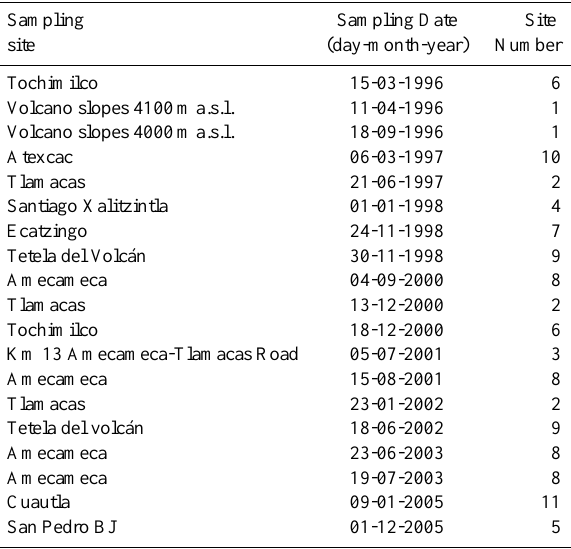
Table 1. Sampling site locations and